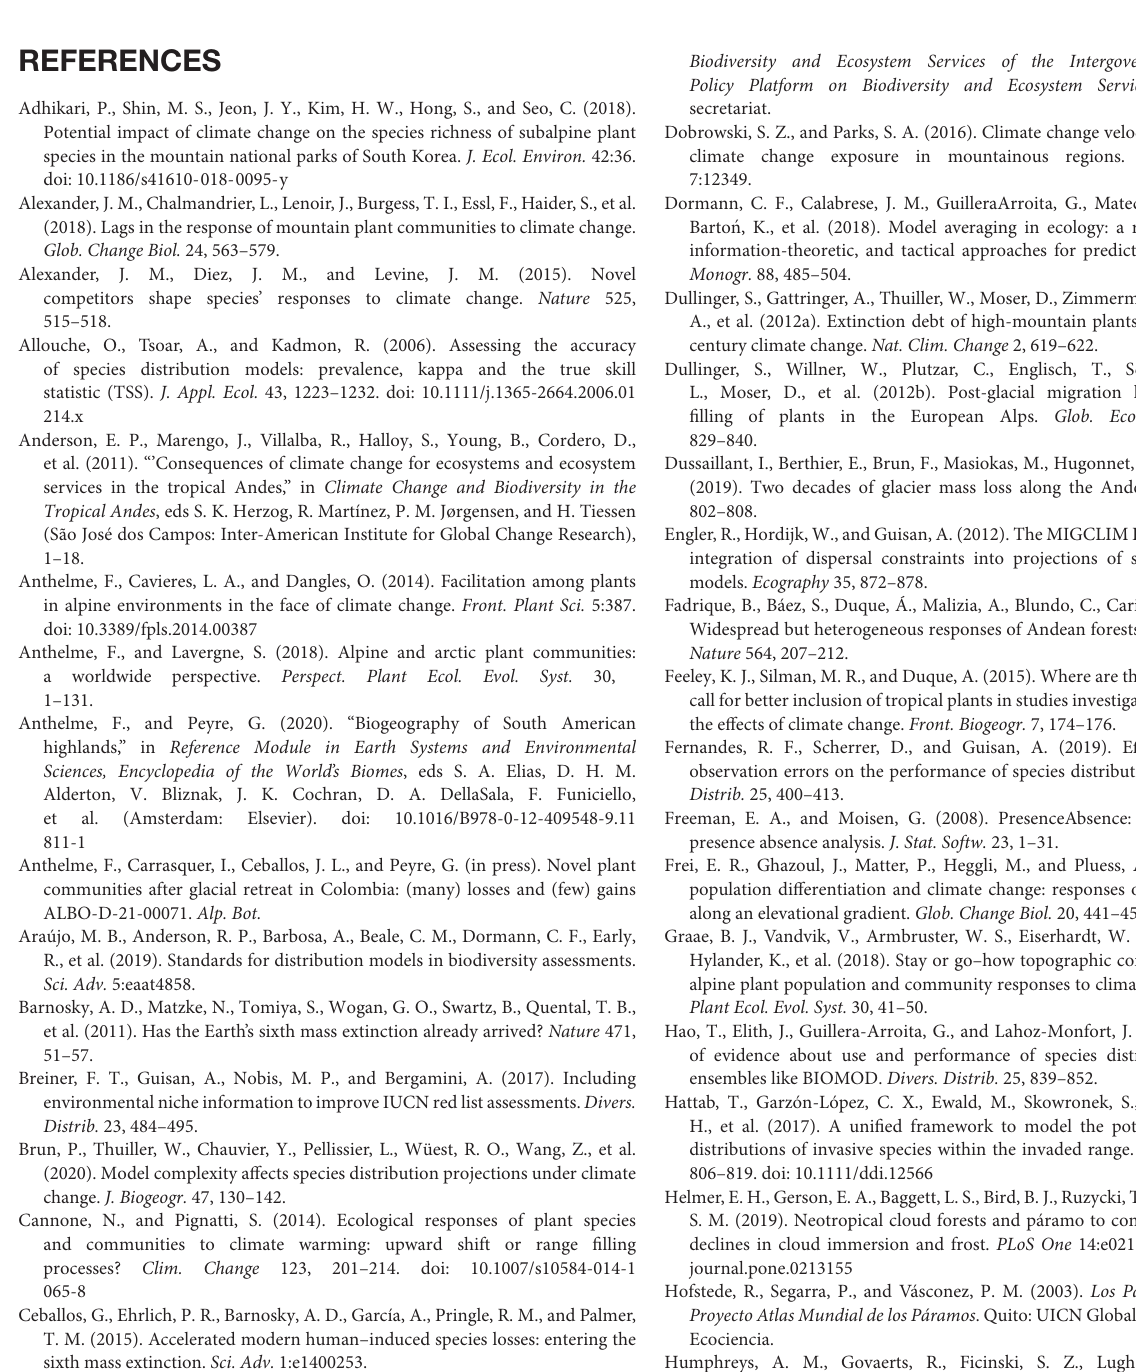
Supplementary Table 2 | Model performance according to the Specificity, Sensitivity and TSS metrics for the four employed algorithms: ANN, GLM, MARS, and RF, averaged over their 25 runs for each of the 664 studied species (standard deviation in parenthesis), for both the realized and potential species distribution